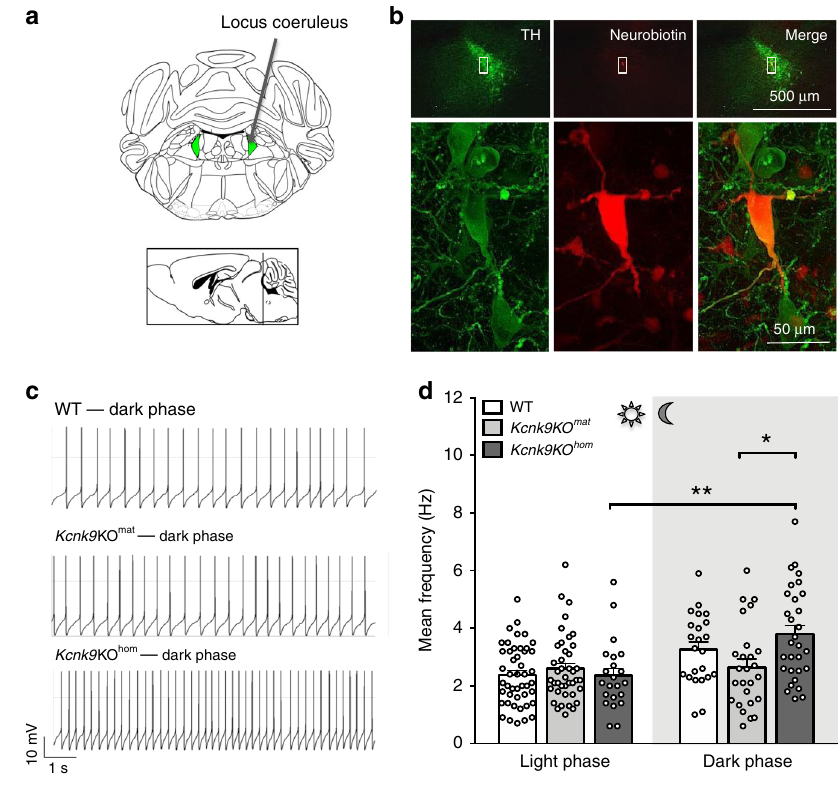
Fig. 3 Electrophysiological analysis of LC neurons. a Schematic overview of the locus coeruleus (LC) and its position in the adult mouse brain, bregma − 5.40 and − 5.52 (the coordinates were according to the mouse brain atlas 43) . Green triangles represent the LC. b Confocal images showing TH-positive signal (green), neurobiotin-positive signal (red) and a merge of both signals (yellow). Upper images show an overview of the LC at a low-magni fi cation (×4) and lower images display signals of analyzed single-cell at high-magni fi cation (×60 oil). c Electrophysiological traces of single cells in the night phase of WT, Kcnk9 KO mat and Kcnk9 KO hom animals. Recordings from synaptically isolated spontaneously active LC neurons reveal increased pacemaker frequency in LC neurons from Kcnk9 KO hom mice during dark phase. d Scatter dot-plot of mean frequencies including all analyzed cells in the day and night phase of WT (light n = 46, N = 5, dark n = 23, N = 3), Kcnk9 KO mat (light n = 41, N = 5, dark n = 26, N = 4) and Kcnk9 KO hom (light n = 22, N = 3, dark n = 30, N = 5) animals. Ordinary one-way ANOVA with Bonferroni ’ s multiple comparison post hoc test, * P < 0.05, ** P < 0.01. Values are means ± SEM. N = number of mice, n = total number of cells. Statistical analyses and approaches are provided in Supplementary Table 1. Source data are provided as a Source Data fi